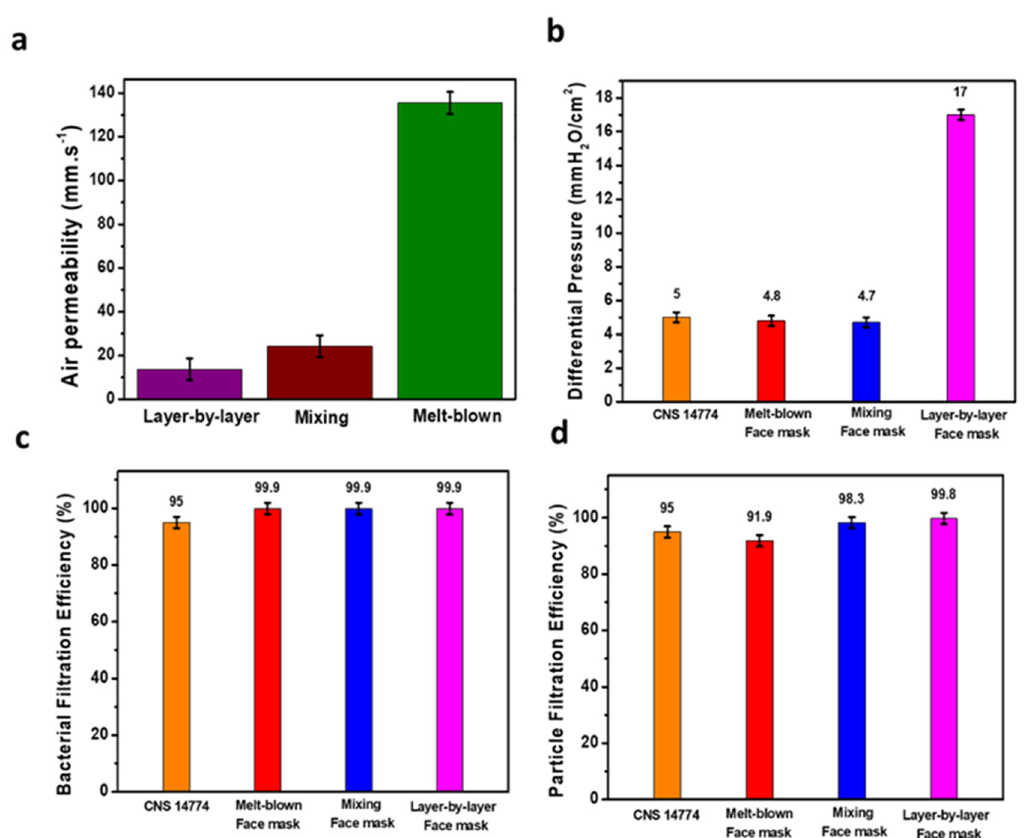
Figure 7. Melt-blown, mixing, and layer-by-layer fabrics are investigated for air permeability ( a ), differential pressure ( b ), Bacterial Filtration Efficiency ( c ), and Particle Filtration Efficiency ( d ) tests.